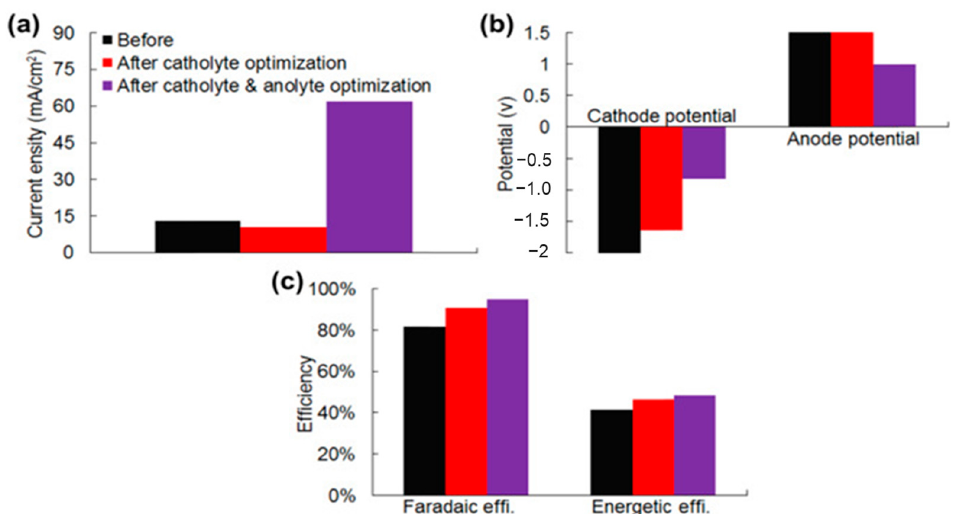
Figure 3. The performance characteristics of the dual electrolyte microfluidic reactor (DEMR): ( a ) current densities at an applied voltage of 2.8 V before and after electrolyte optimizations; ( b ) cathode potentials at 100 mA/cm 2 and catholyte pH values of 7, 1 and 0, and anode potentials at 150 mA/cm 2 and anolyte pH values of 7, 13 and 14; ( c ) peak Faradaic and energy efficiencies before and after electrolyte optimization. Reproduced with permission from ref. [37]. Copyright 2016, Elsevier.